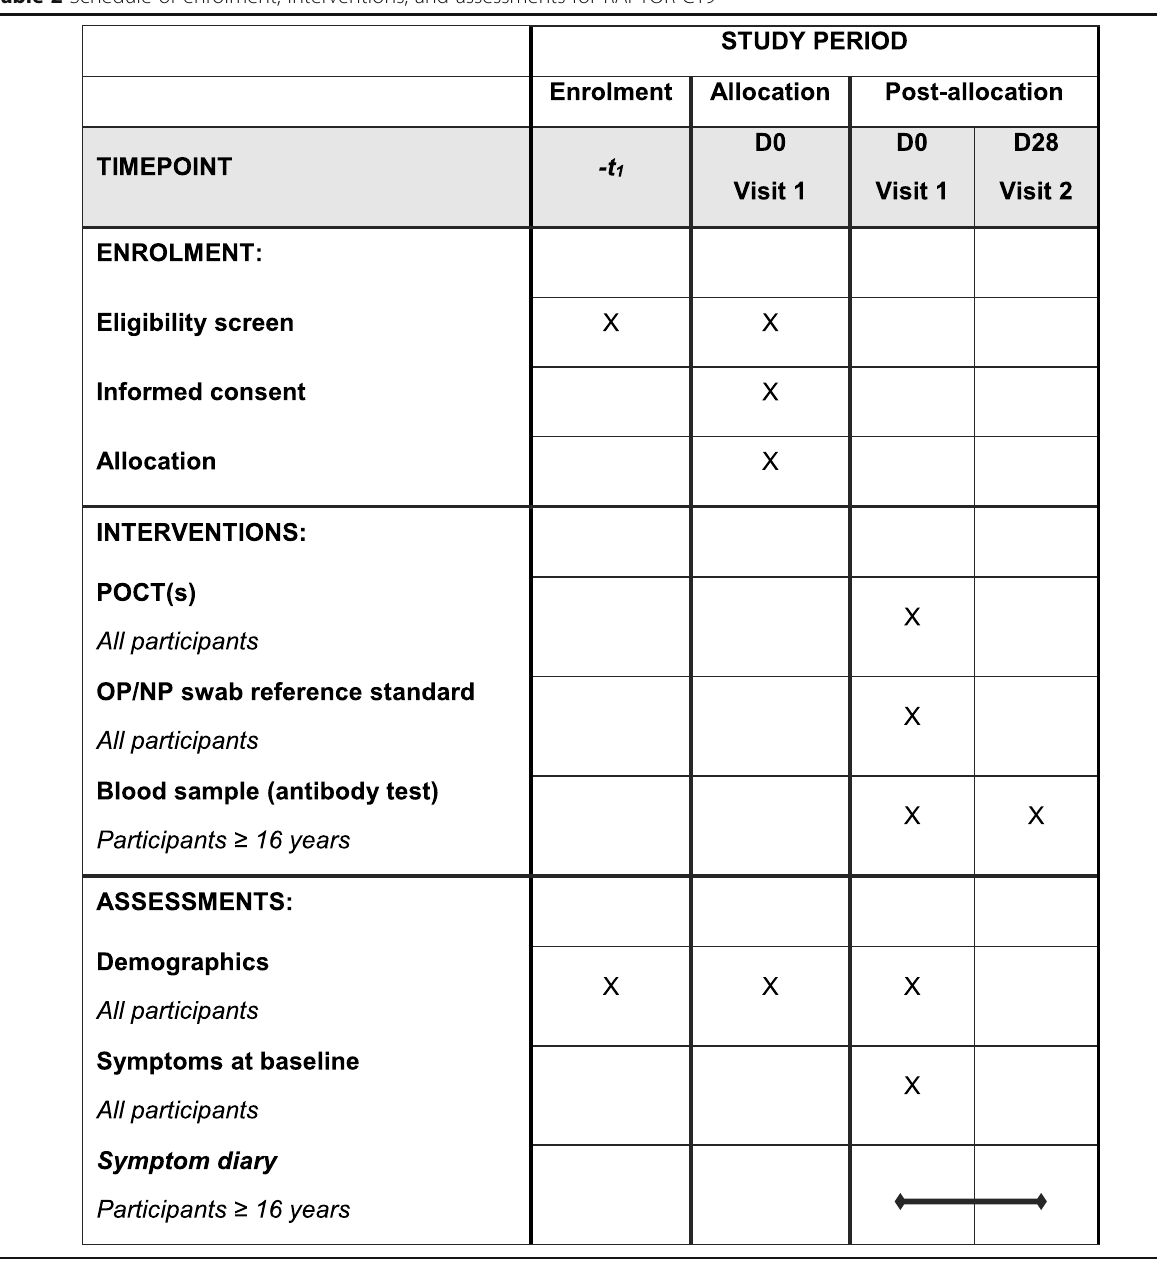
Table 2 Schedule of enrolment, interventions, and assessments for